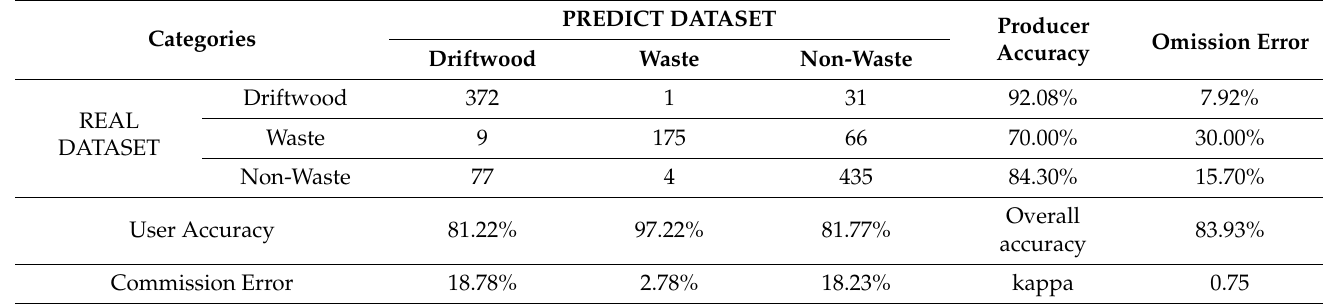
Table 4. Confusion matrix for MLP.